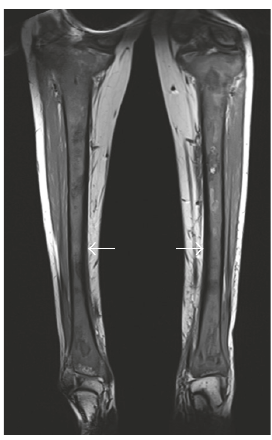
Figure 2: Bilateral tibial coronal T1 MRI showed bilateral asymmet- rical hypointense lesions replacing the normal fatty signal intensity of both tibiae as compared to the normally appearing marrow fat signal in the talus. Note also the cortical thickening noted in the tibial cortices medially (arrows).